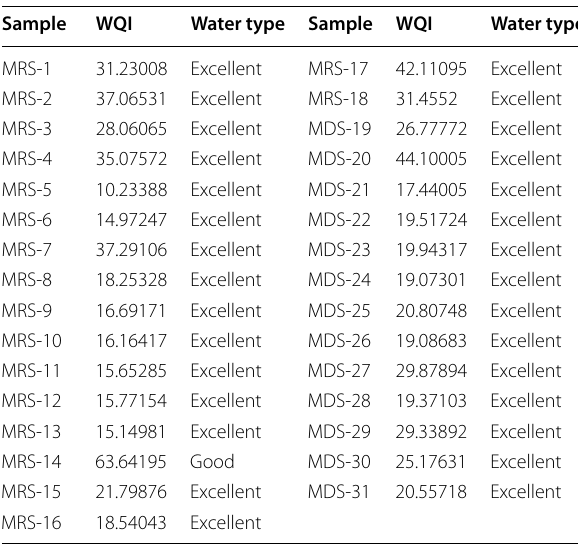
Table 9 Calculated Water Quality Index and their classifi- cation of the